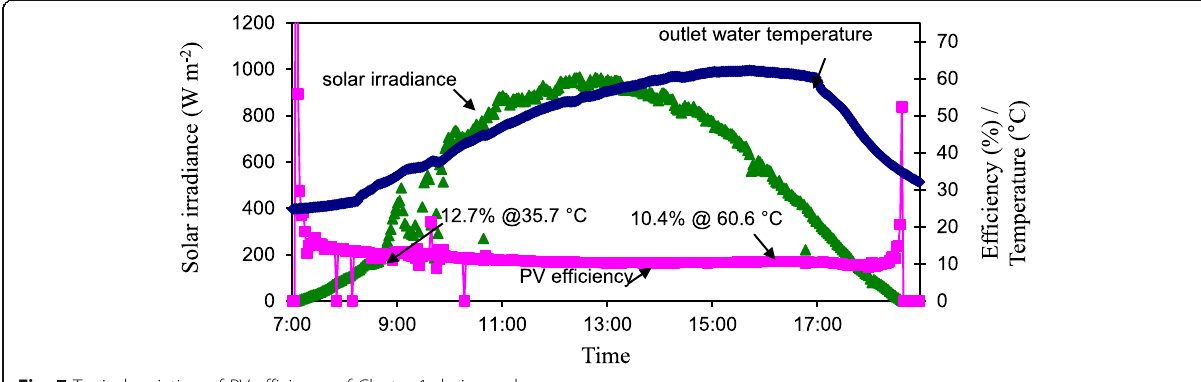
Fig. 7 Typical variation of PV efficiency of Cluster 1 during a